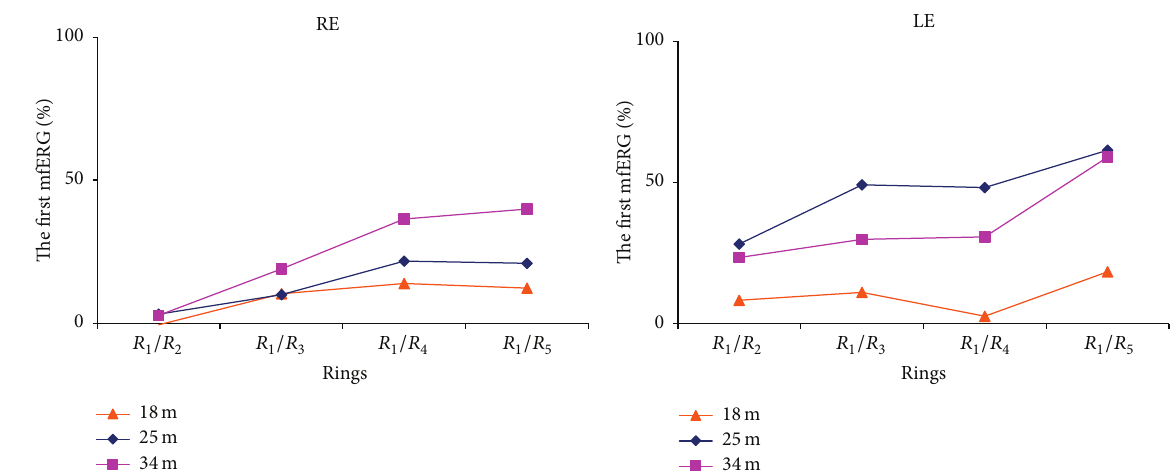
Figure 4: Percentage of change in rings ratios of mfERGs made at 18, 25, and 34 months when compared with those of the first mfERG, obtained 4 months after hydroxychloroquine dose reduction. LE: left eye. RE: right eye.